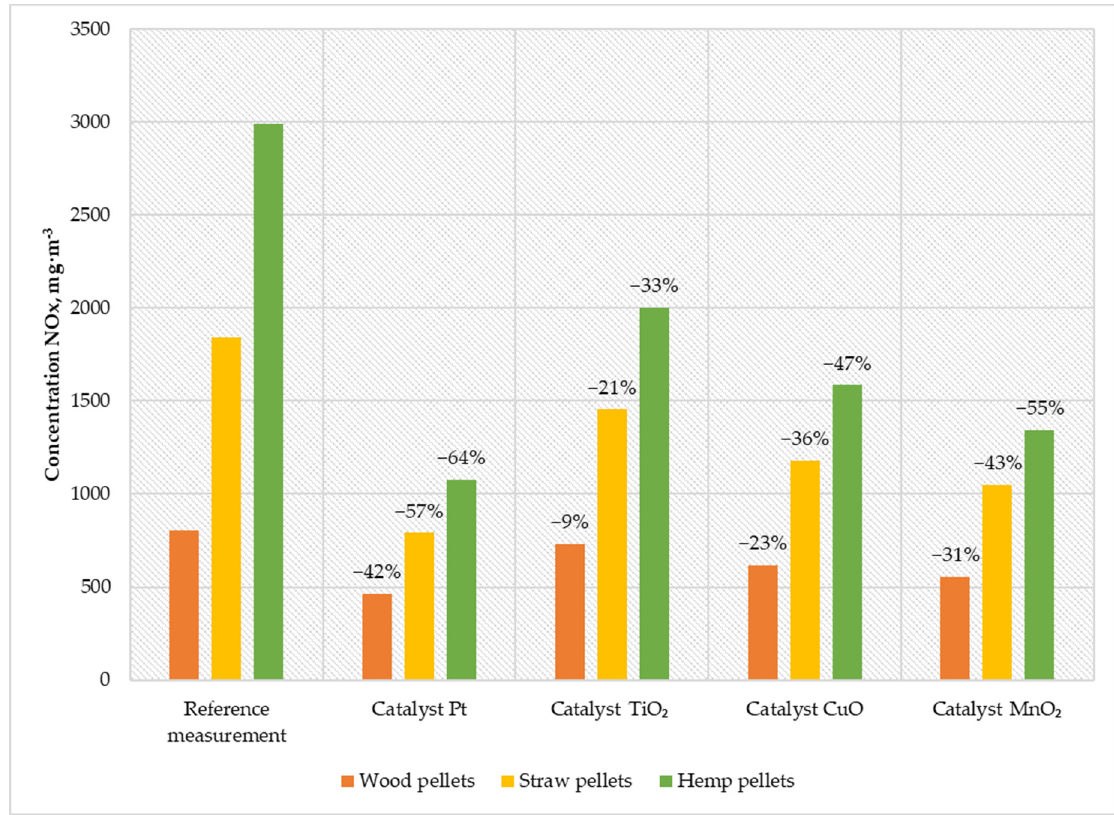
Figure 6. Average NO X content in the flue gas from a low-power biomass boiler.